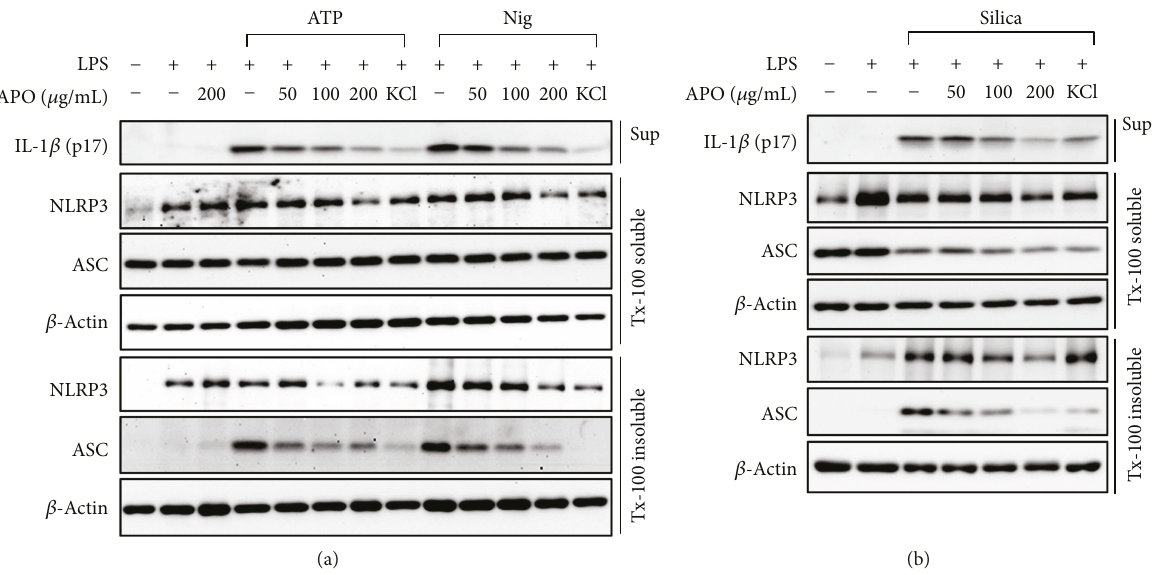
Figure 3: E ff ect of APO on ASC translocation during in fl ammasome activation. LPS-primed BMDMs were pretreated with APO or KCl (150mM), and IL-1 β secretion was determined by Western blotting upon stimulation with (a) 5mM ATP, 10 μ M nigericin for 1 h, and (b) 150 μ g/mL silica for 3 h in the supernatant (Sup). NLRP3 and ASC distribution was estimated by Western blotting of the soluble and insoluble fractions of Triton X-100. β -Actin was used as an internal control in each fraction. LPS, lipopolysaccharide; BMDMs, bone marrow-derived macrophages; APO, A. princeps extract; IL, interleukin; Nig,